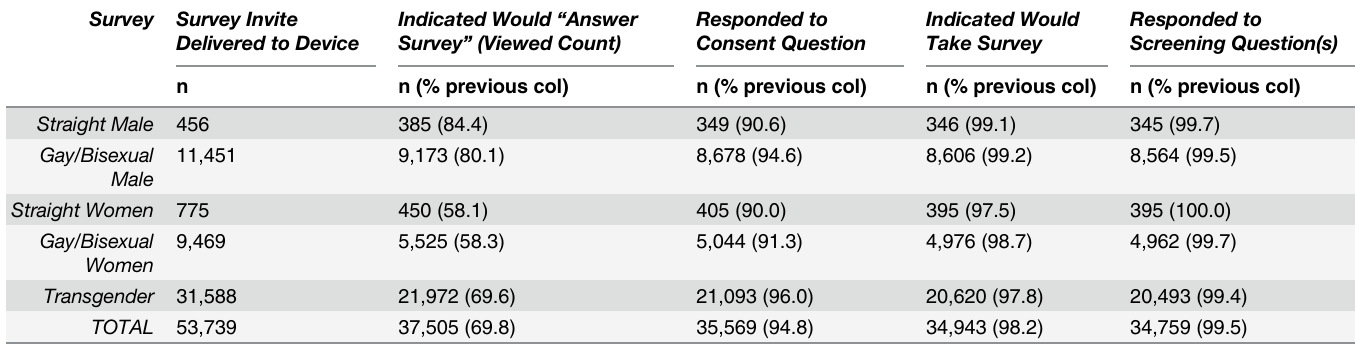
Table 1. Survey Response